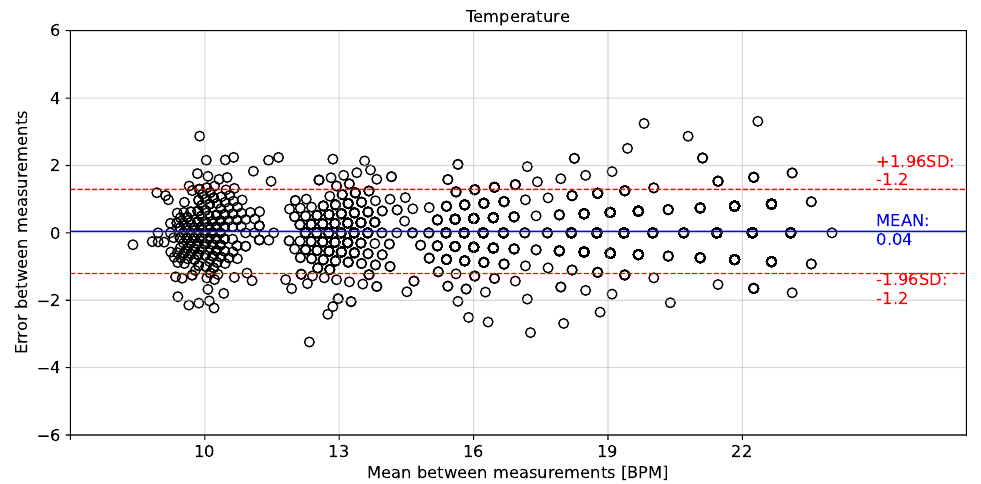
Figure 16. Bland–Altman plot for instantaneous breathing rate using temperature signal compared to airflow signal.